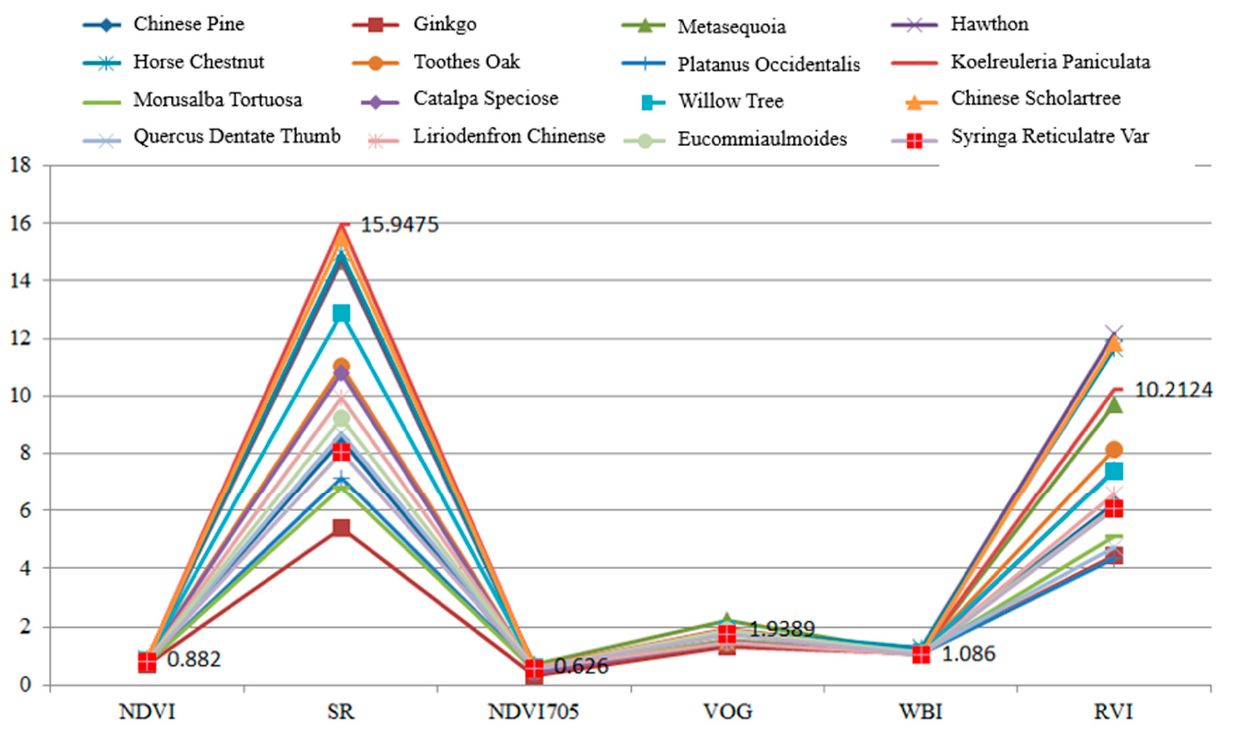
Figure 12. Parameters of the employed leaves.